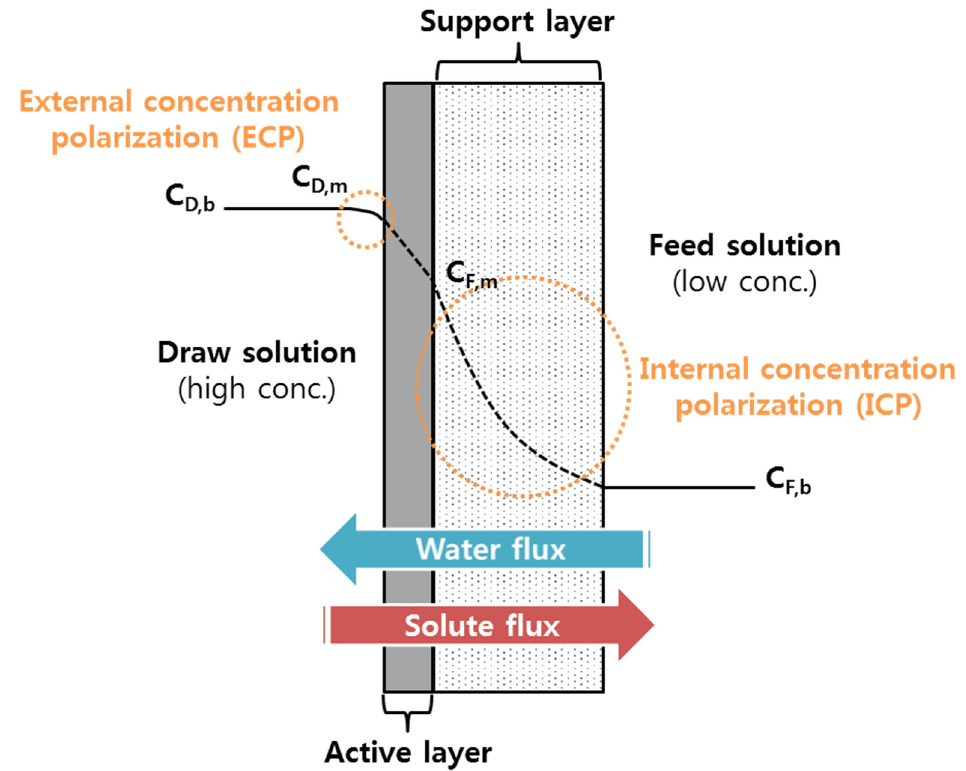
C and C are the , Db , F b C is the concentration , Dm